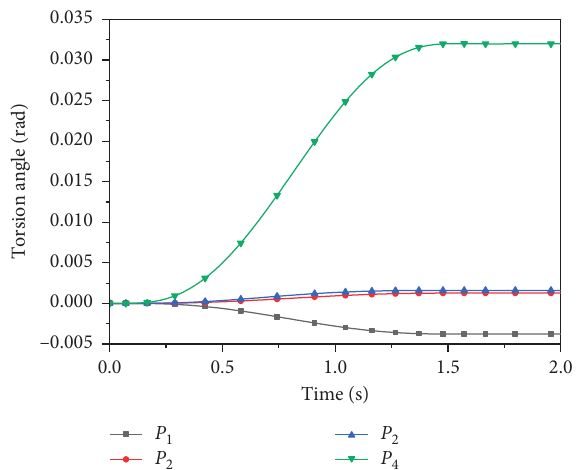
Figure 7: Time evolution of the torsion angle of each spring coil endpoint in the compression process.